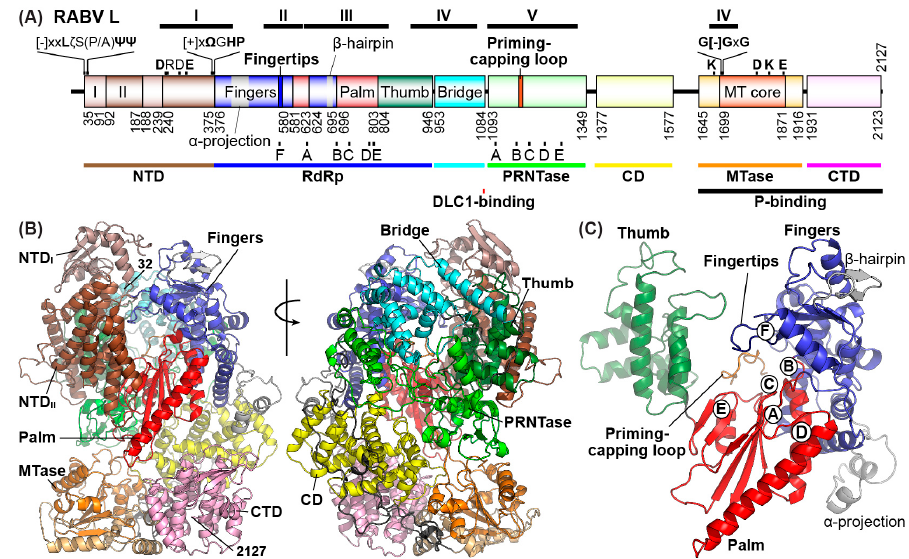
Figure 4. A structural model of the rabies virus (RABV) large (L) protein. ( A ) The domain organization of the RABV L protein was predicted as reported for the vesicular stomatitis virus (VSV) L protein [8]. The predicted domains and subdomains are colored as follows: NTD, N-terminal domain (subdomains: I, light brown; II, brown); RdRp, RNA-dependent RNA polymerase (subdomains: fingers, blue; palm, red; thumb, dark green); Bridge (cyan); PRNTase, GDP polyribonucleotidyltransferase (green); CD, connecter domain (yellow); MTase, methyltransferase (MTase core, orange; other regions, light orange); CTD, C-terminal domain (pink); linker regions between domains (black). Numbers indicates the positions of amino acid residues beginning and ending the domains and subdomains. The positions of the conserved regions (I–VI) [105], RdRp motifs (A–F), PRNTase motifs (A–E), and other motifs are shown [8]. [ − ], [+], ζ , Ψ , Ω , and x indicate negatively charged, positively charged, hydrophilic, aliphatic, aromatic, and any amino acids, respectively. Binding sites for the RABV P protein and host DLC1 are indicated below the schematic. ( B ) A three-dimensional structure of the RABV L protein (RC-HL strain, GenBank id: AB009663) was predicted with SWISS-MODEL [122] using the structure of the VSV L protein (PDB id: 5A22) as a template. Two views of the structure are shown as ribbon models, in which domains and subdomains are colored as in ( A ). The extended linkers between the PRNTase/CD and CD/MTase domains are visible and noted in in the model to the right. The linkers were not modeled in the previous VSV structure. Amino acid residues at positions 32 and 2127 (C-terminal end) are indicated. N-terminal residues 1–31 are not present in the model. ( C ) The predicted structure of the RABV RdRp domain is shown. The positions of RdRp motifs A–F are denoted by circled capital letters. The priming-capping loop extended from the PRNTase domain is shown in orange. Rhabdovirus-specific substructures in the fingers subdomain are colored gray. All structural images were prepared with PyMOL [123]. The coordinates of the modeled RABV L protein have been uploaded to the Model Archive (www.modelarchive.org, id: ma-pe4nf).